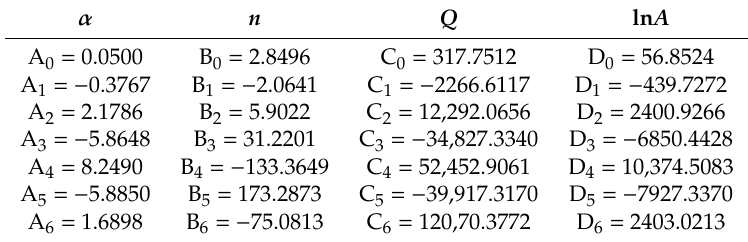
Table 2. Polynomial fitting results of α , n , Q , and ln A for the Mg-16Al